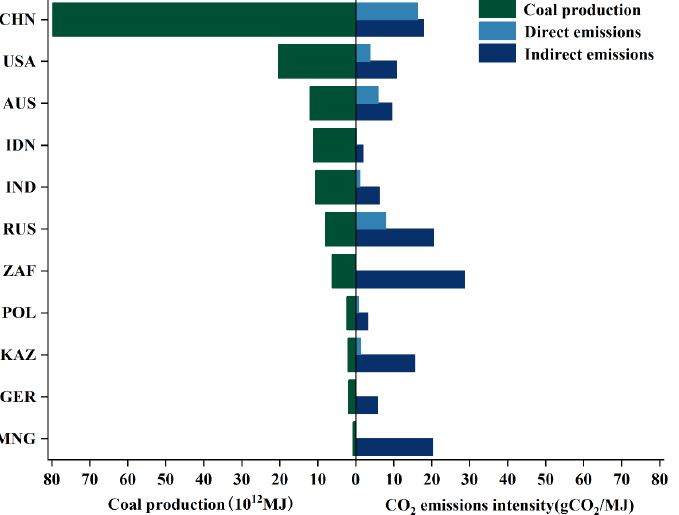
Figure 2. CO 2 emission intensity of coal production in different